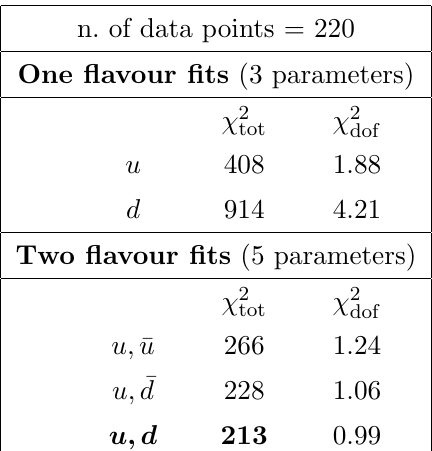
Table 1 . Comparison of minimal (cid:31) 2 values obtained by (cid:12)tting the Sivers asymmetries according to the model of eqs. (2.1) to (2.8), under di(cid:11)erent hypotheses for the (cid:13)avour content of F sin( (cid:30) h (cid:0) (cid:30) S )